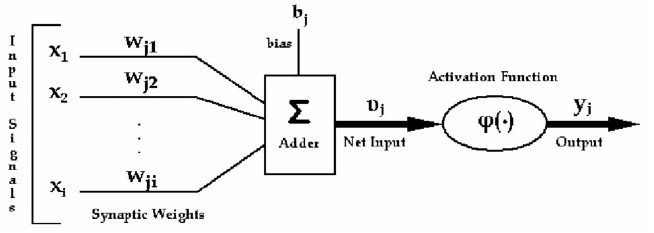
Figure 1. Neural network